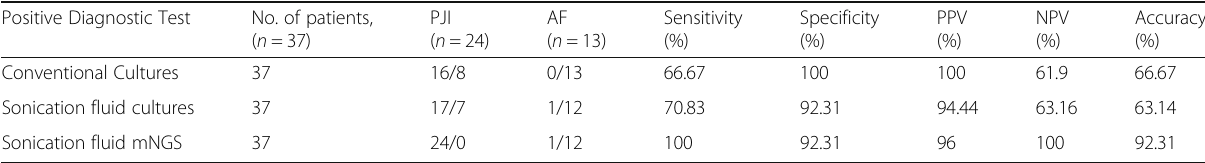
Table 4 Comparison of diagnostic efficiency between culture and mNGS Positive Diagnostic